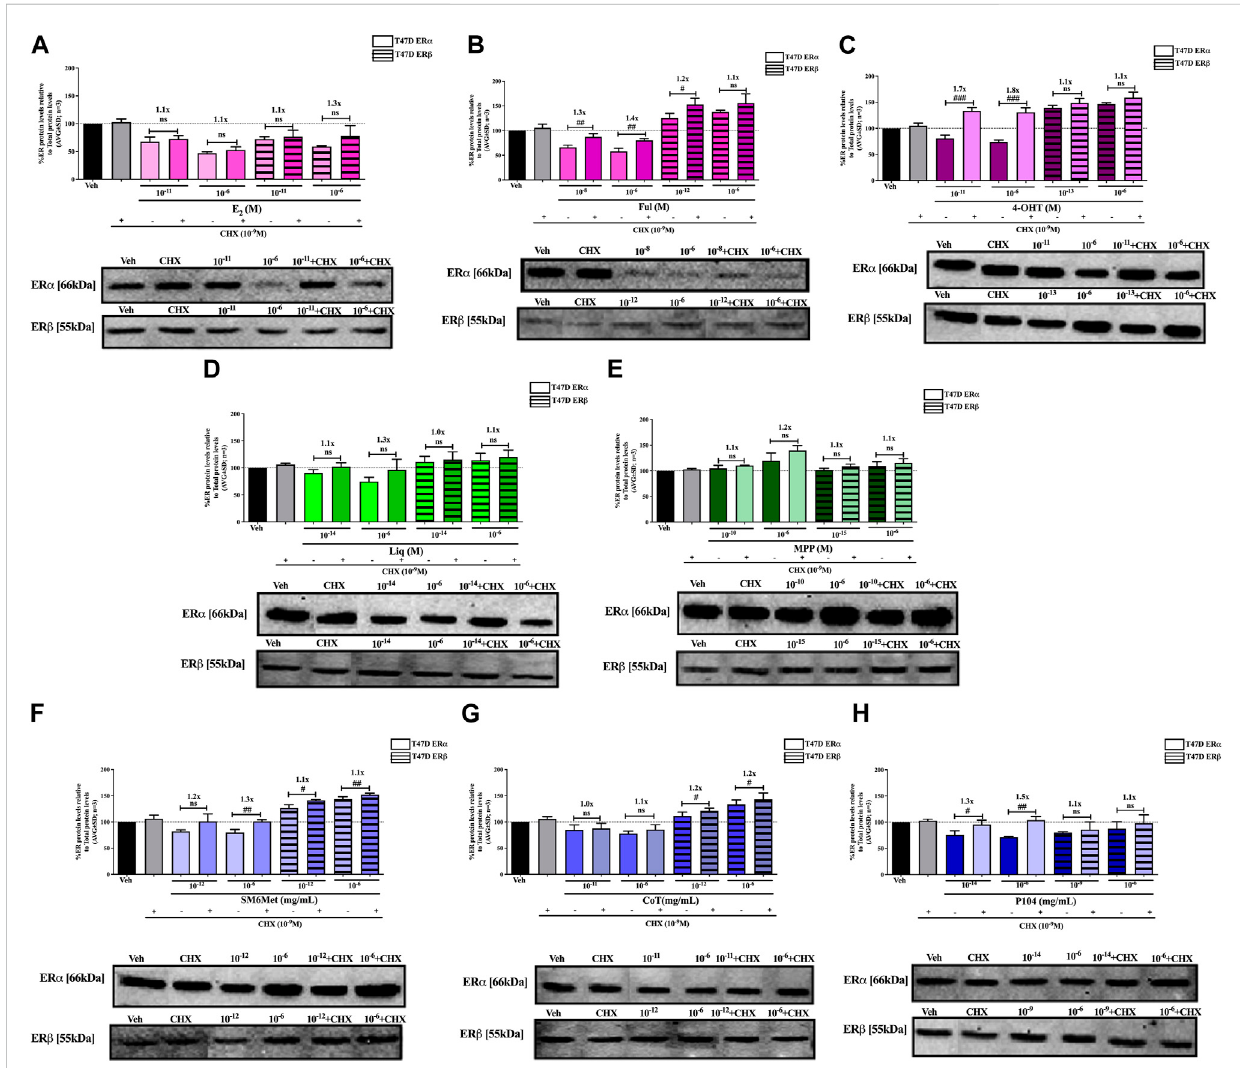
FIGURE 5 Effect of CHX, a protein synthesis inhibitor, on the modulation of ER α and ER β protein levels in T47D cells. T47D cells were steroid starved for 24 h and then treated with either vehicle (DMSO) or LogIC 50 (from Figure 3; Table 2 with µg/ml converted to M) and saturating (1 μ M) concentrations of (A) E 2 or the SOCs, (B) fulvestrant (Ful) or (C) 4-OH-tamoxifen (4-OHT), or the ER subtype selective ligands, (D) liquiritigenin (Liq) or (E) methyl-piperidino- pyrazole (MPP), or LogIC 50 (from Figure 3 in µg/ml) and saturating (10 − 6 μ g/ml) concentrations of the Cyclopia extracts, (F) SM6Met, (G) cup of tea (CoT) or (H) P104 in the presence or absence of 1 nM CHX for another 24 h, after which the effect of ± CHX on ER α and ER β protein levels were determined using Western blot. The western blots shown as insertare representativesofthree independentexperiments. Forquanti fi cation, theintensity oftheER α andER β bandsweredeterminedwithMyImageAnalysissoftware,afterwhichtheobtainedvalueswerenormalizedtototalproteincontentand expressed as a percentage (AVG ± SD) of DMSO, which was set at 100%. Fold-change is indicated above the bars. Statistical analysis was done using a two-tailed t -test to establish signi fi cant differences due to addition of CHX ( # p < 0.05, ## p < 0.01 and ### p <